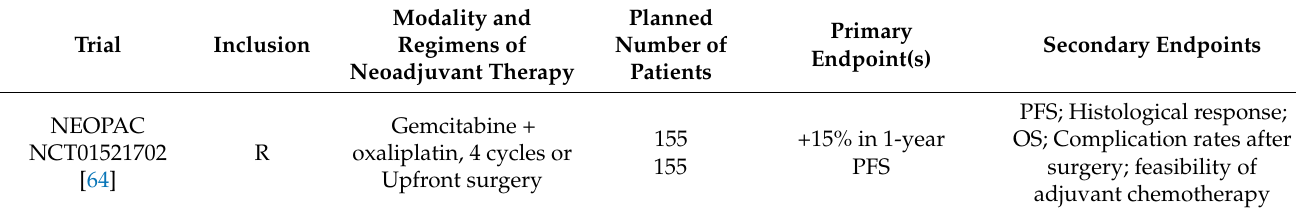
Table 3. Ongoing randomized clinical